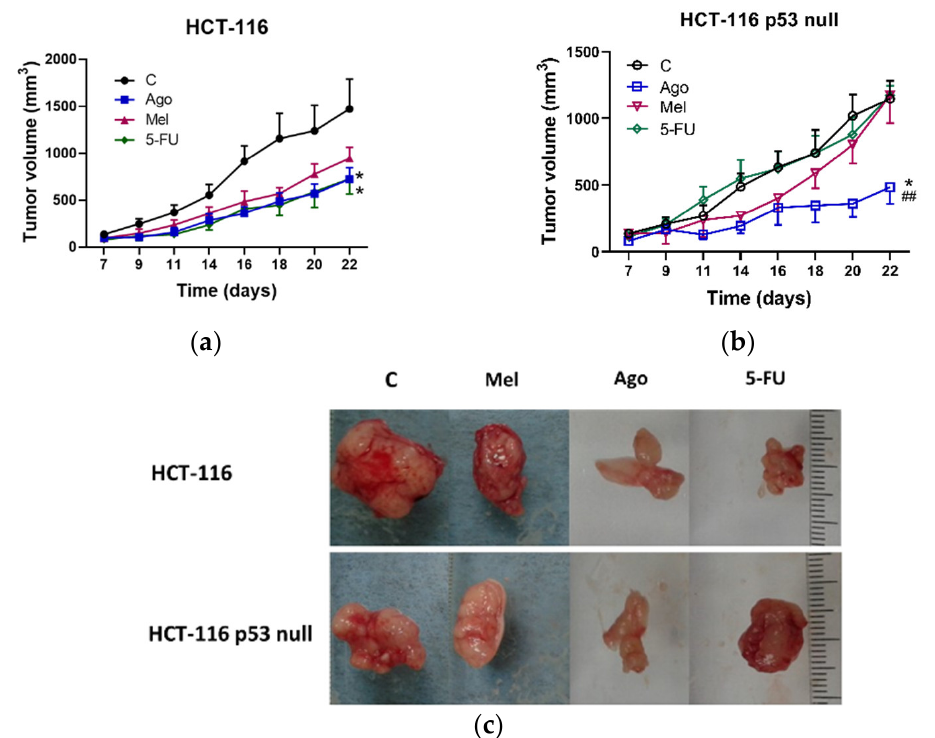
Figure 4. Tumor growth in the four groups of nude mice (controls and those treated with agomelatine, melatonin, or 5-FU, as described in Materials and Methods) in cell-line-derived xenografts in either ( a ) HCT-116 or ( b ) HCT-116 p53 null. Data represent mean ± SEM. * p < 0.05 vs. control mice; ## p < 0.01 vs. 5-FU group. ( c ) Representative images of tumors in control and treated mice in cell-line-derived xenografts. C: control; Mel: melatonin; Ago: agomelatine; 5-FU: 5-fluorouracil.